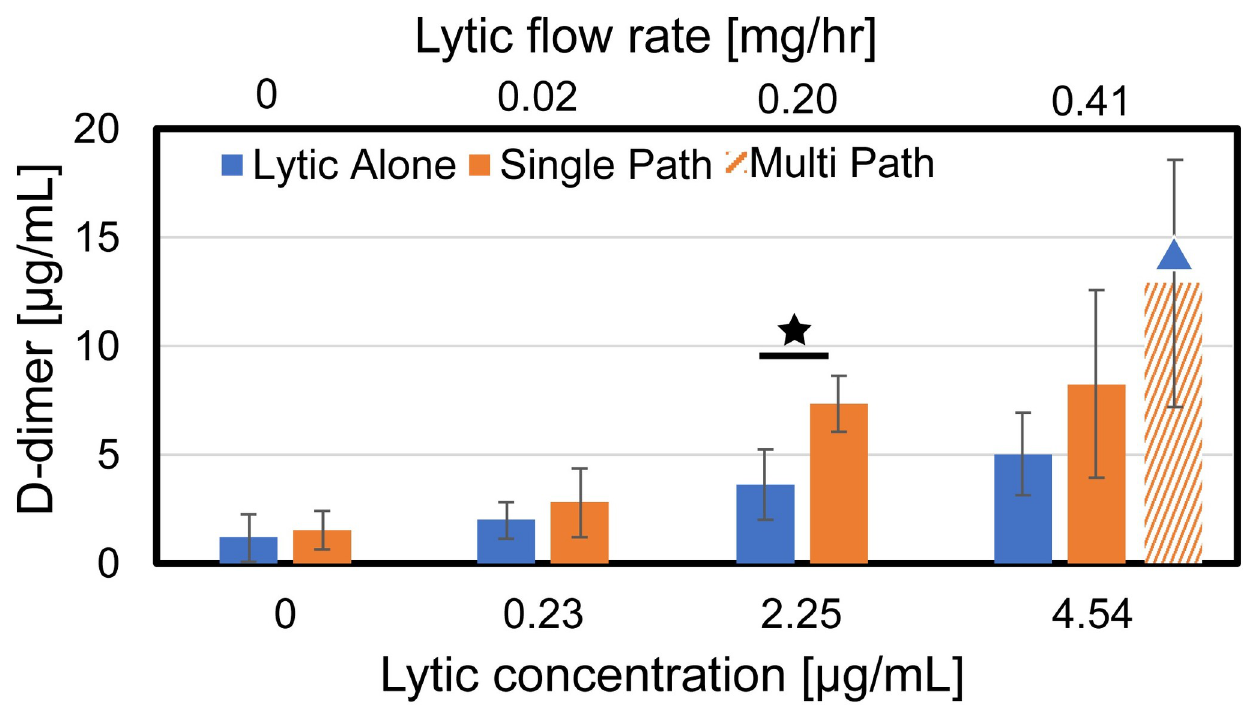
Fig 5. The concentration of D-dimer generated for each treatment arm. Stars indicate statistically significant increases in mass loss for a given concentration of the lytic rt-PA (p < 0.05). The blue triangle indicates a significant increase compared to the standard of care arm (4.54 μ g/mL, no histotripsy). The legend indicates the insonation scheme used for clot